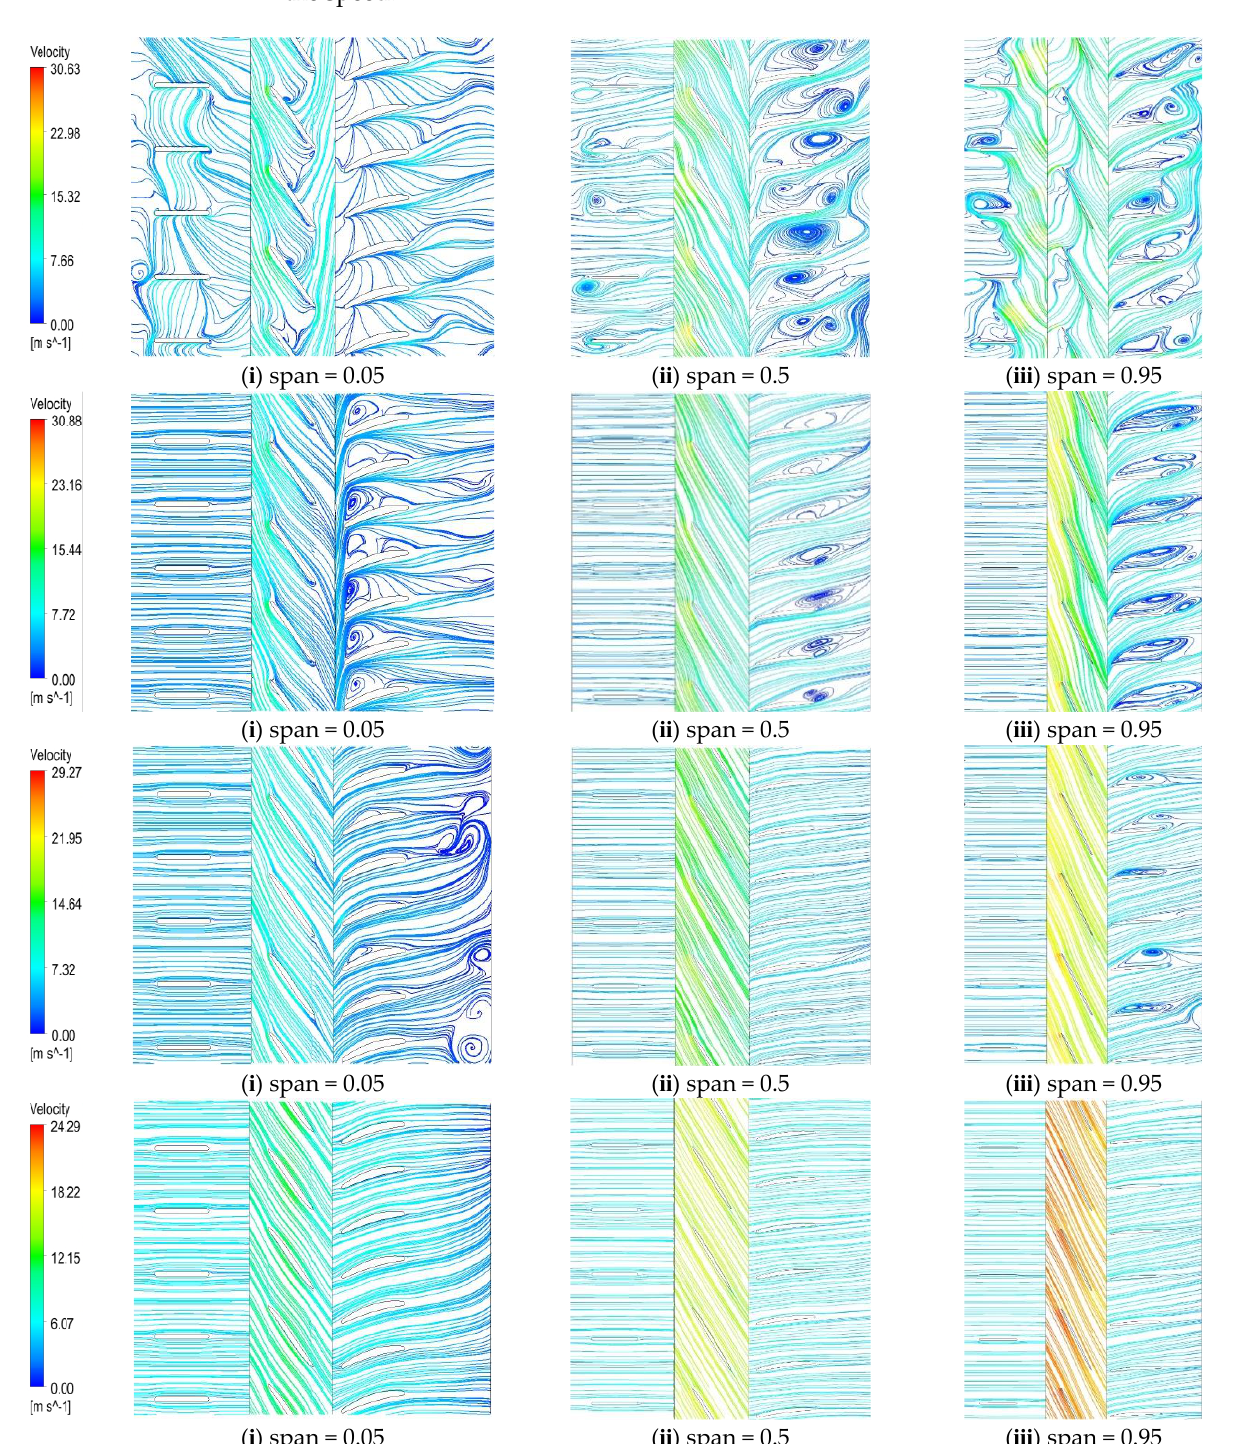
Figure 16. Velocity streamline distribution under pump condition. ( i ) span = 0.05. ( ii ) span =